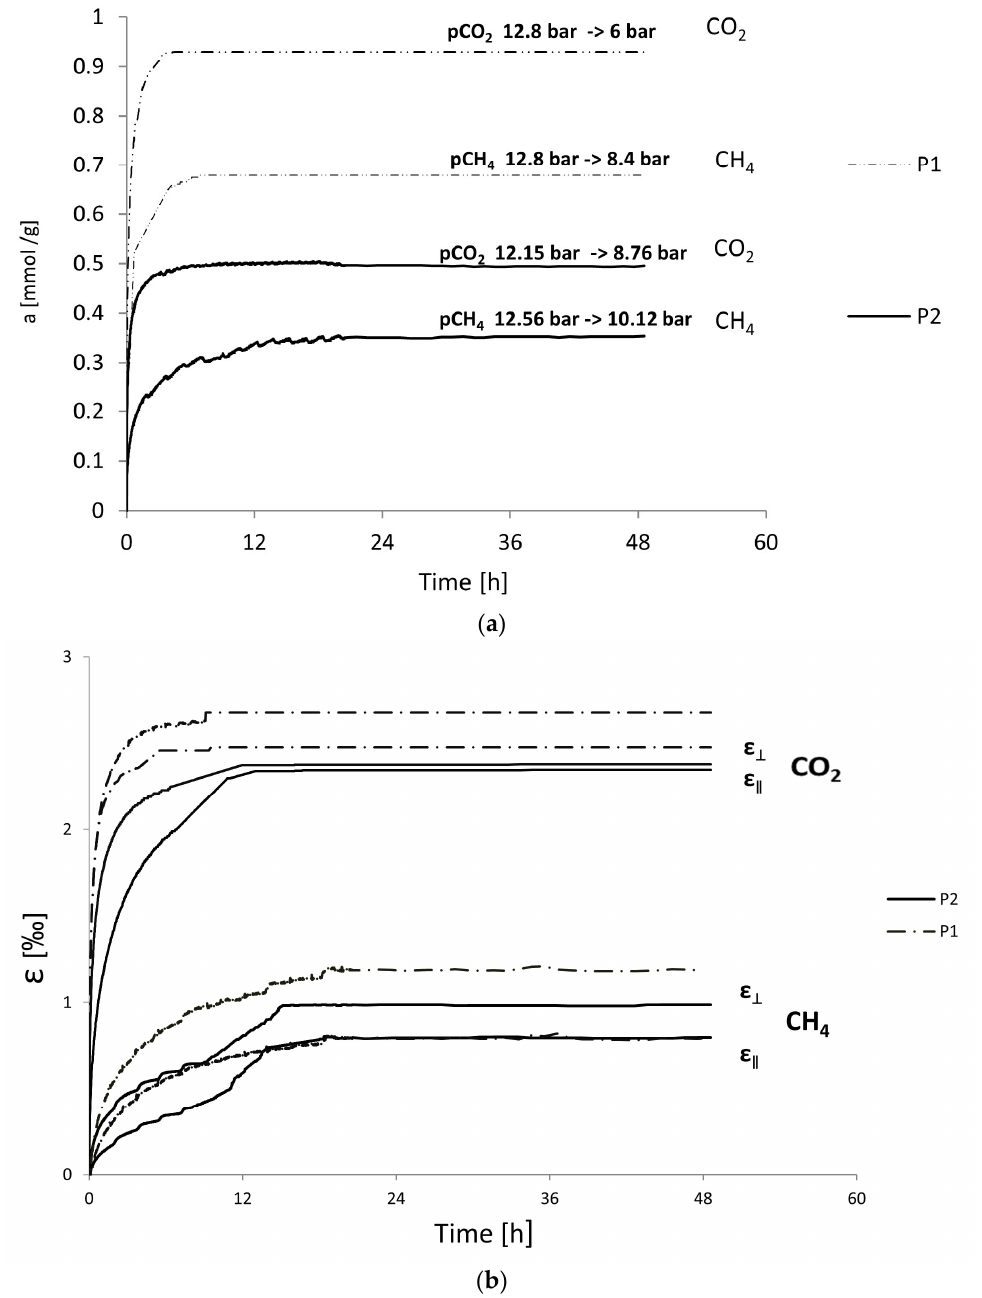
Figure 4. ( a ) Kinetics of CO 2 and CH 4 sorption. ( b ) Linear strains at 298 K for sample P1 and sample P2. Table 2. Specification of the tested